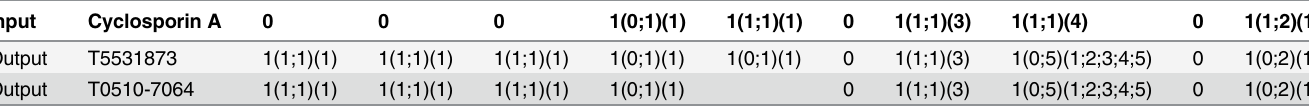
Table 1. Matching quantum scores of input and output molecules from cyclosporine.